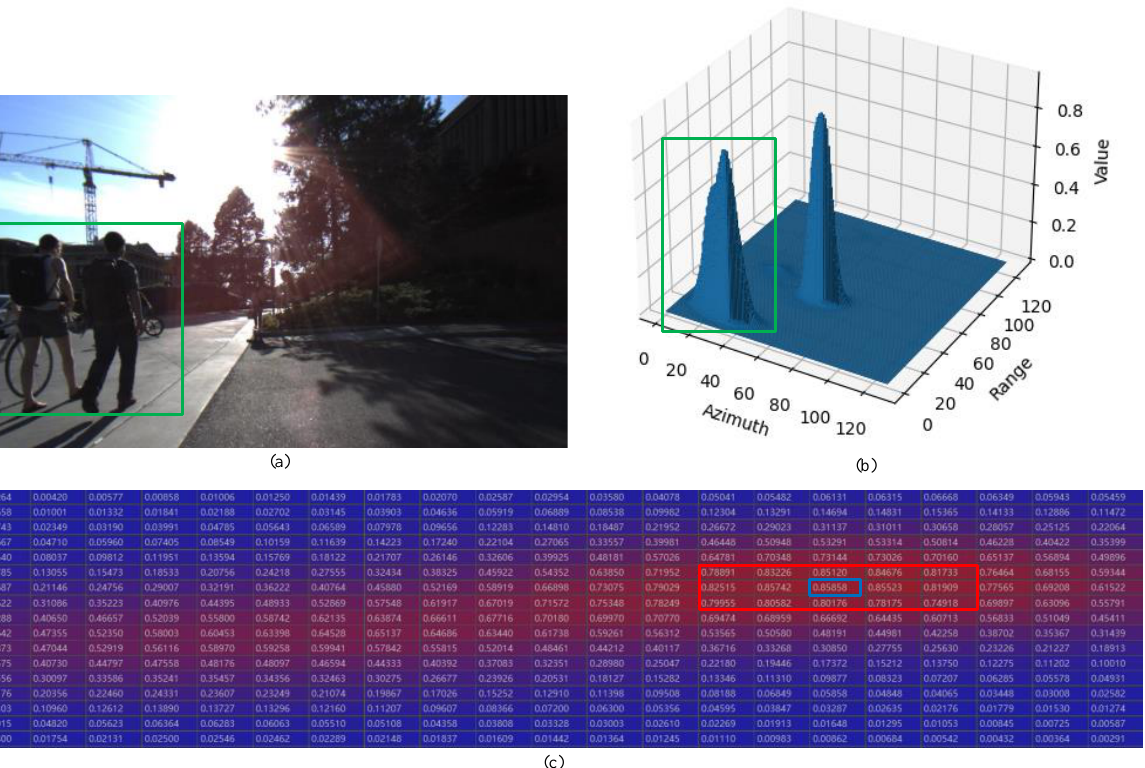
Figure 10. Case (3) data. ( a ) Optical photo of case (3). ( b ) A 2D ConfMap of case (3). ( c ) A 3D ConfMap of case (3). The red box in ( c ) represents a 3 × 5 slider, and the blue box represents the result of the primary screening peak. The area corresponding to ( c ) is the position indicated by the green box in ( a , b ).